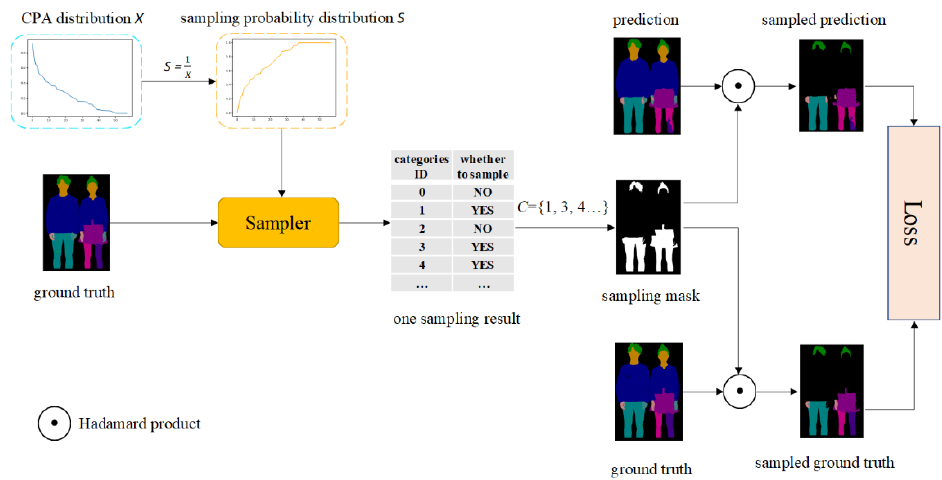
Figure 4. The structure of PRA. First, we calculate the sampling frequency distribution according to the CPA distribution, and the sampler samples the categories in the real label according to the sampling frequency distribution, and then generates the sampling mask. The sampling mask is used to perform a Hadamard product with the model prediction and the ground truth to obtain the sampled prediction and the sampled ground truth.